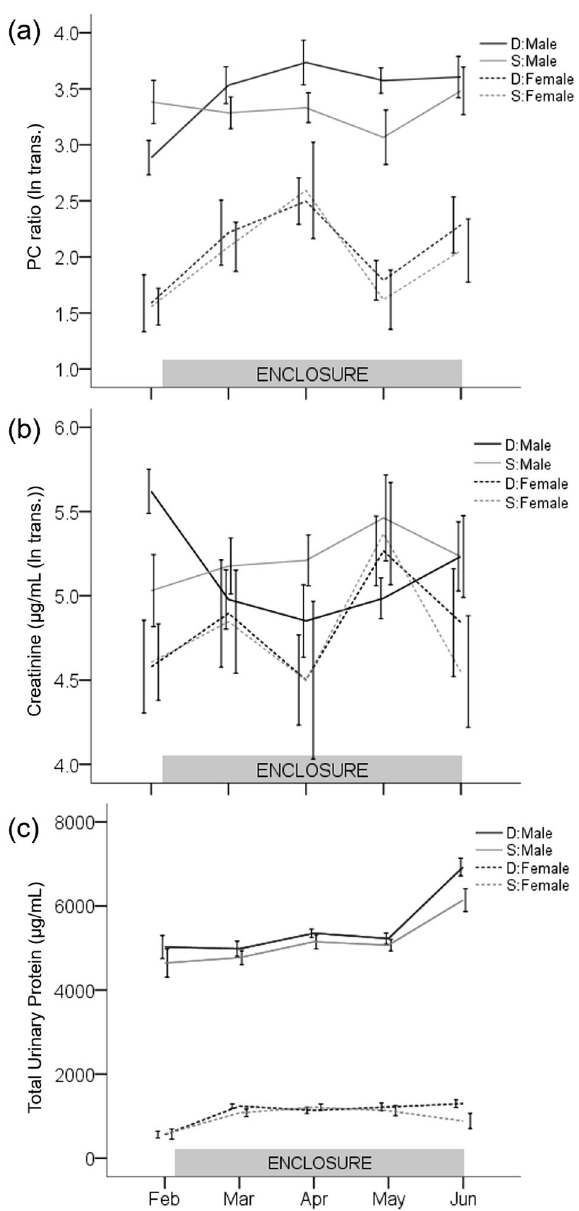
Figure 3. Expression of urinary protein in relation to enclosure phase. Line graphs of PC ratio (ln transformed, a ), urinary creatinine concentration (µg mL −1 (ln transformed, b )), and total urinary protein concentration (µg mL −1 , c ). Solid and dashed lines indicate males and females, respectively. Black and gray color indicate dominant (D) and subordinate (S) social status, respectively. Note, February is the before enclosure phase measurement; all other time points were during. Error bars are ± 1